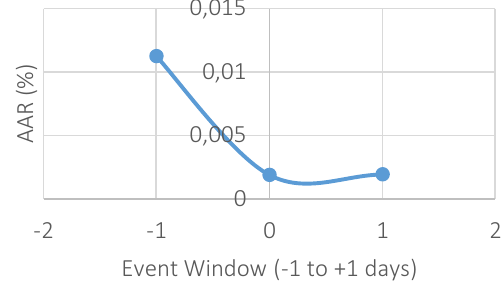
Figure 8. Average abnormal returns for the period of (–1, 0) days